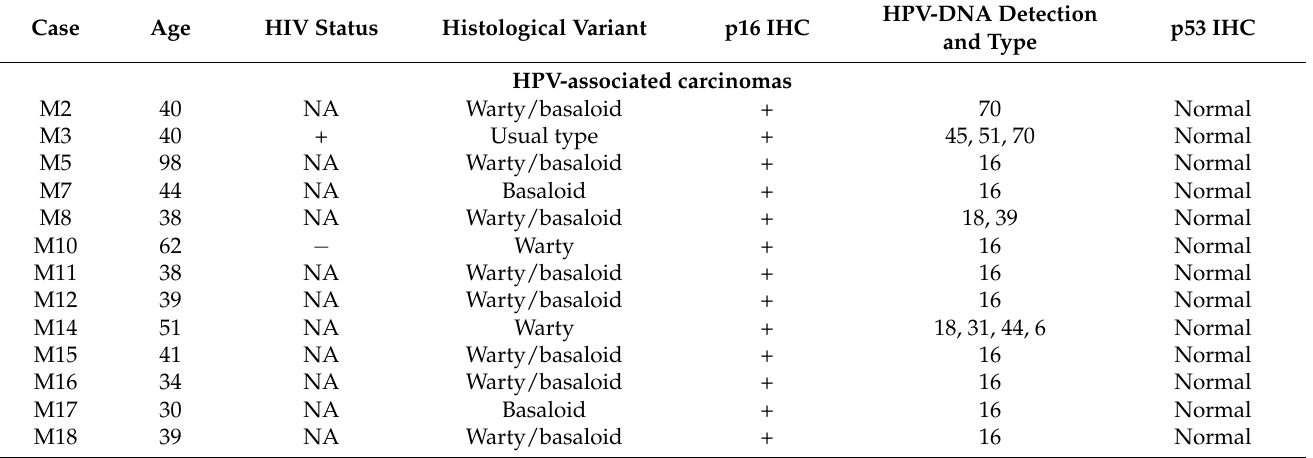
Table 1. Age, HIV status, histological variant, Human Papillomavirus (HPV)-DNA result, p16 and p53 immunohistochemical features of the tumors from